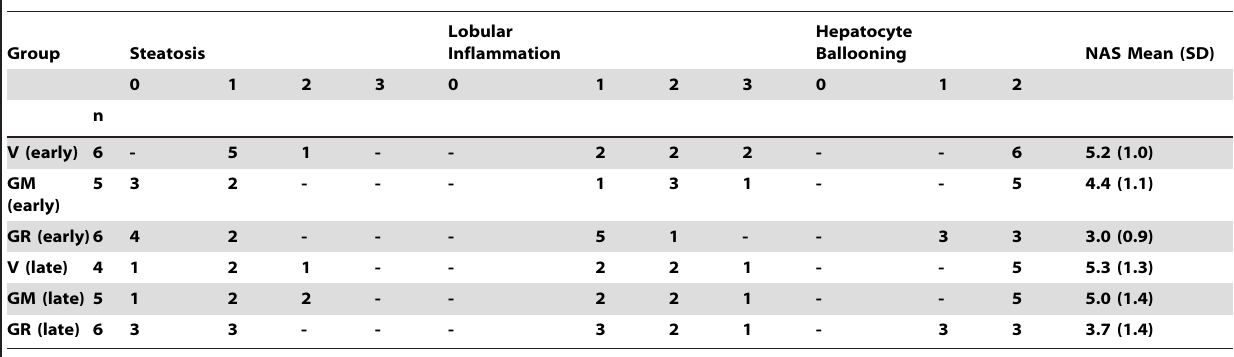
Tabulation of scoring of steatosis, lobular inflammation, hepatocyte ballooning, and NAFLD activity score in liver sections performed as described in Methods on liver sections obtained from animal livers from the experiment described in Figure 1.